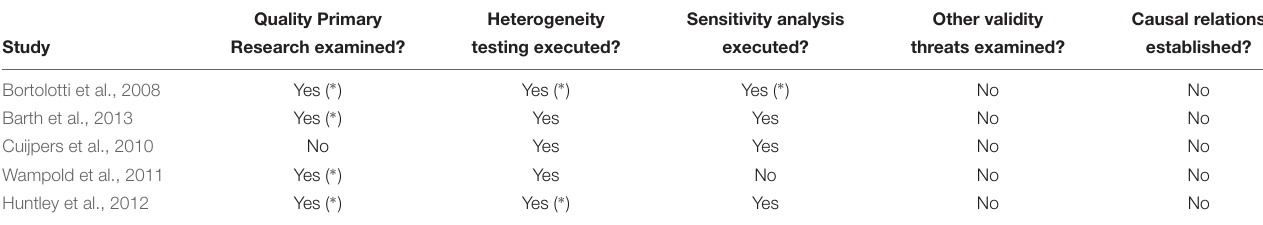
TABLE 2 | Where the five quality assessment parameters